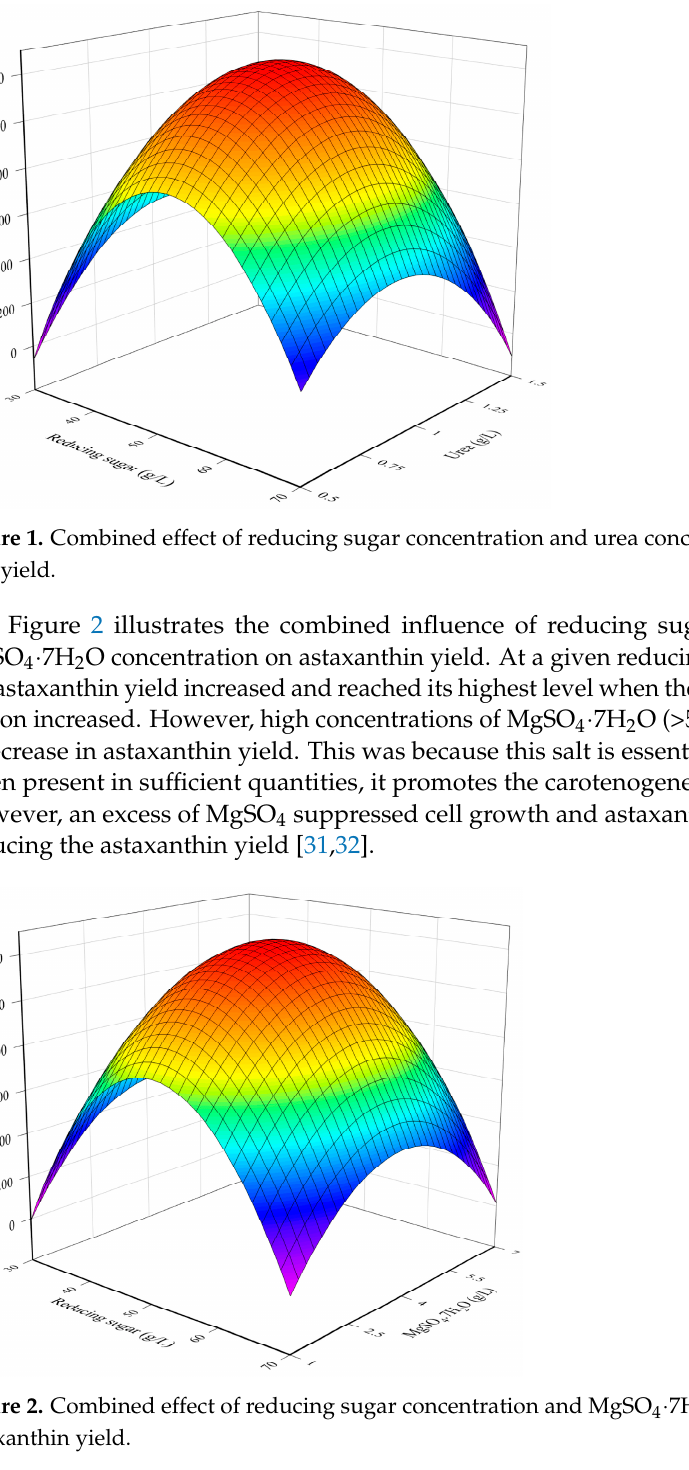
Figure 2. Combined effect of reducing sugar concentration and MgSO 4 ∙ 7H 2 O concentration on the astaxanthin